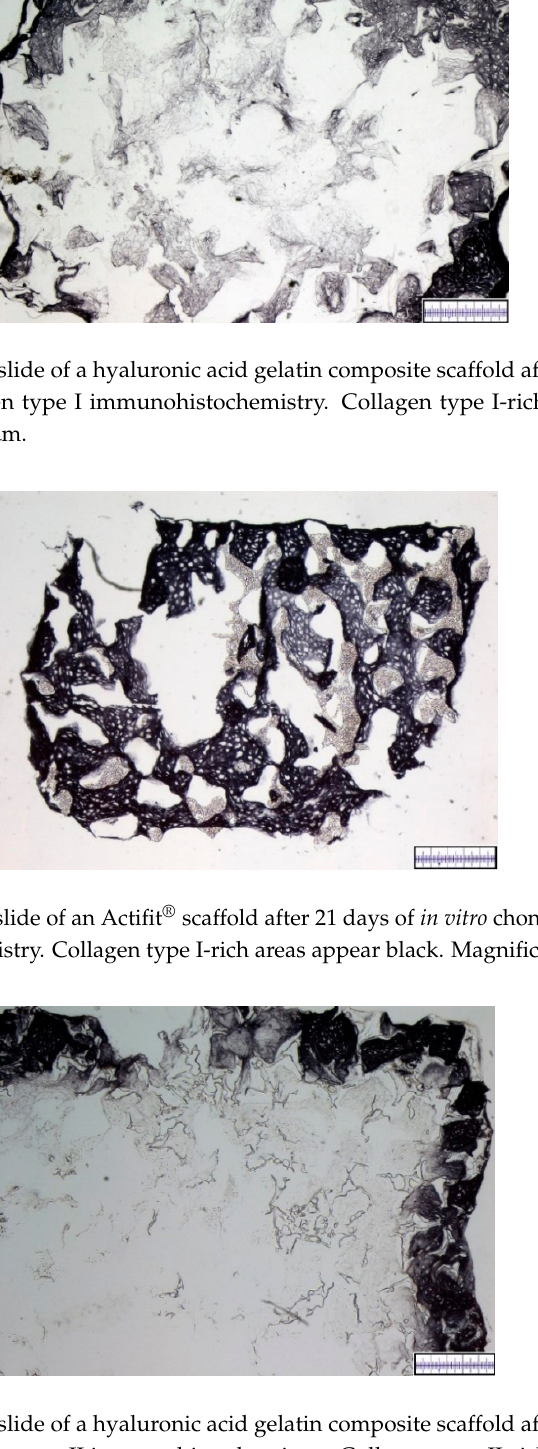
Figure 6. Representative histological slide of an Actifit ® scaffold after 21 days of in vitro chondrogenesis. DMMB staining. Proteoglycan-rich extracellular matrix appears red, scaffold parts appear grey and porous. Magnification bar = 500 μ m.